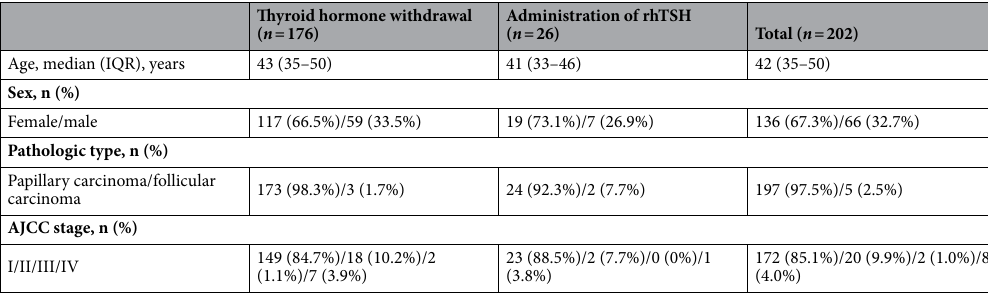
Administration of rhTSH ( n = 26)